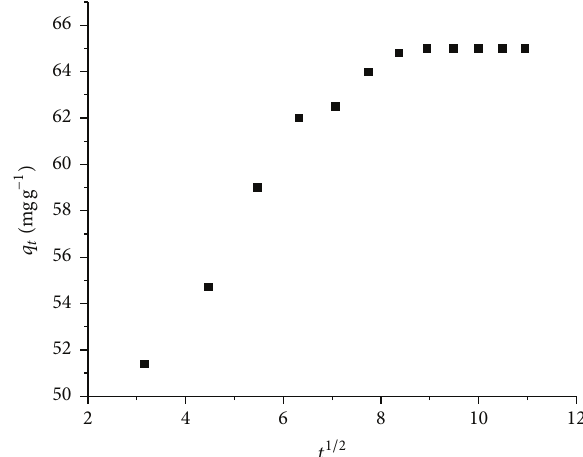
Figure 13: Intraparticle diffusion of Hg(II) adsorption onto ALP